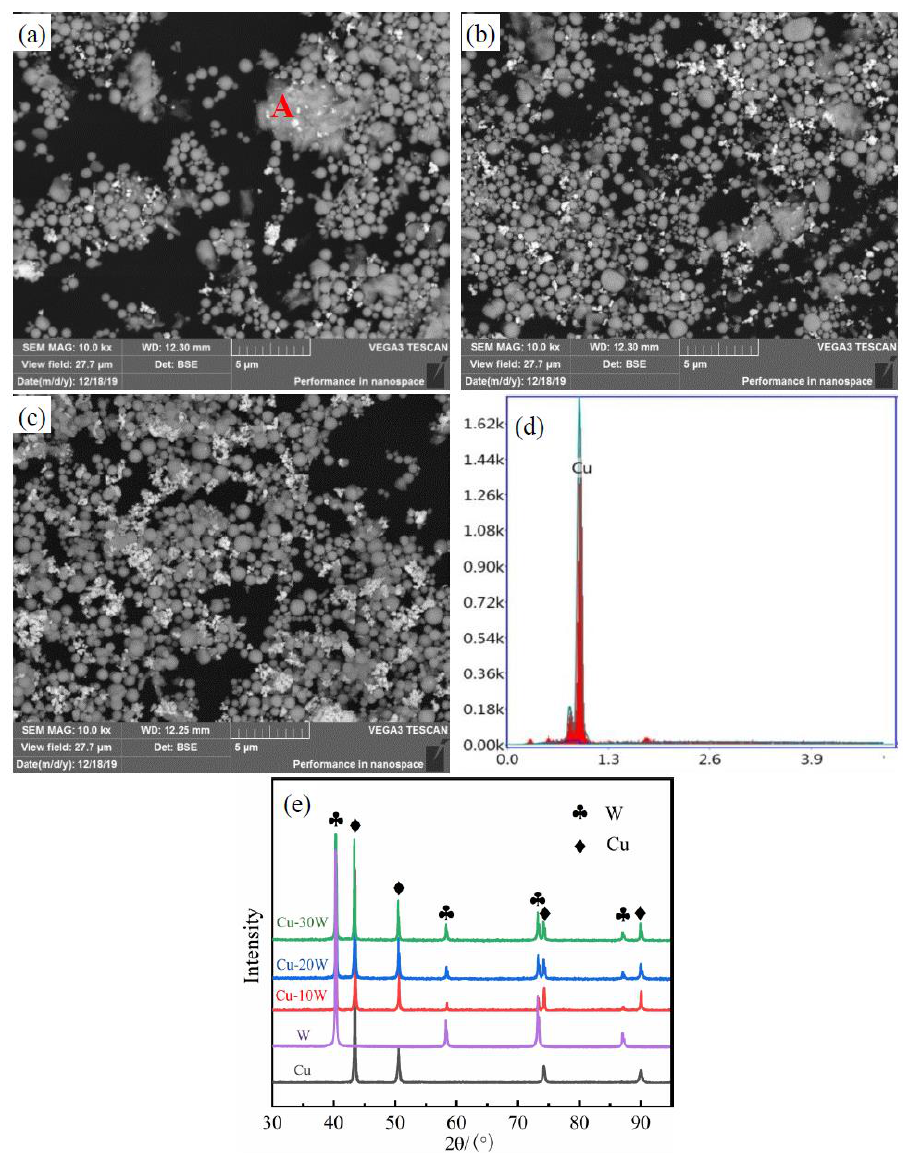
Figure 3. Microstructure of Cu-W composite powders with different W contents: ( a ) Cu-10 wt% W; ( b ) Cu-20 wt% W; ( c ) Cu-30 wt% W; ( d ) EDS analysis of area A in ( a ); ( e ) XRD patterns of pure Cu, pure W and Cu-W composite powders.